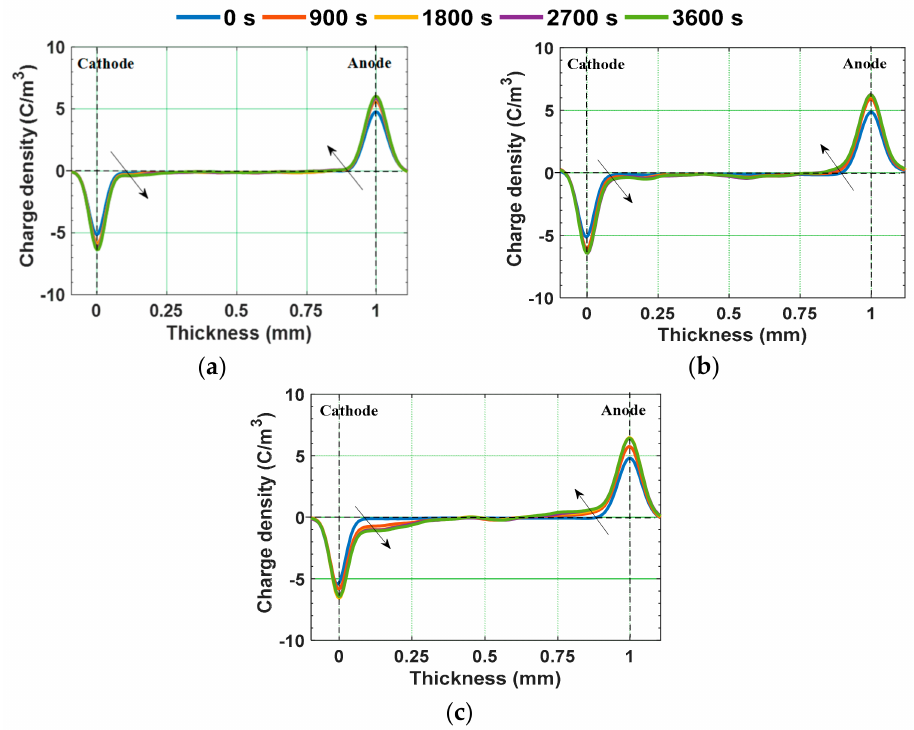
Figure 14. Space charge profiles during poling in ( a ) unaged, ( b ) water aged sample at RT, and ( c ) water aged sample at 90 ◦ C [30].